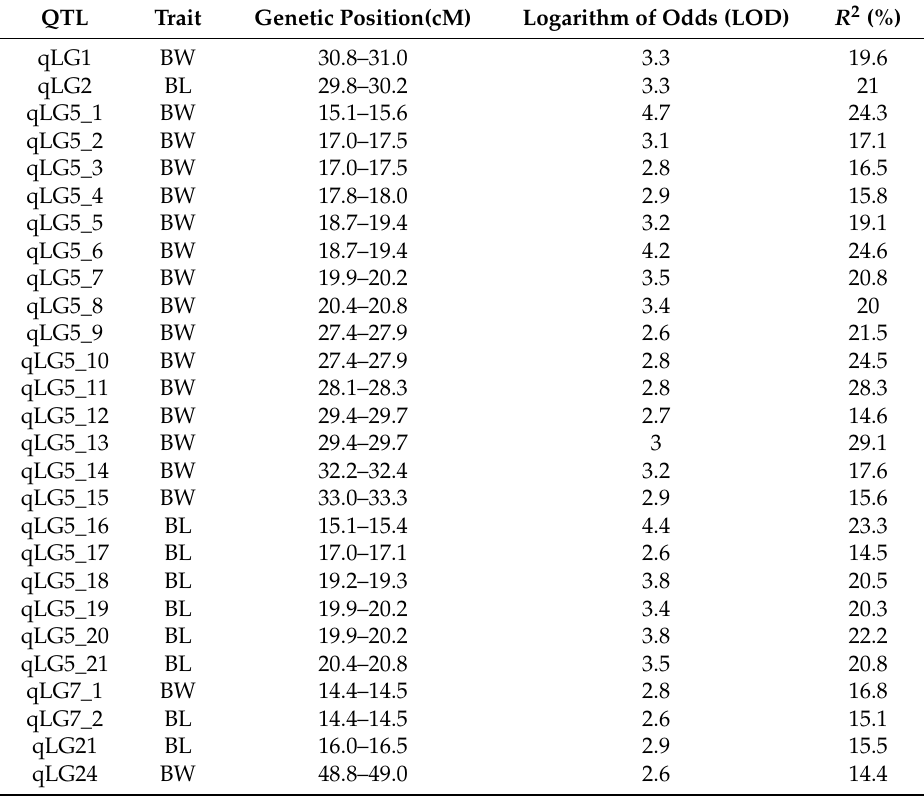
Table 1. The information of growth-related quantitative trait loci (QTLs) for body weight (BW) and body length (BL) in orange-spotted grouper. QTL Trait Genetic Position(cM) Logarithm of Odds